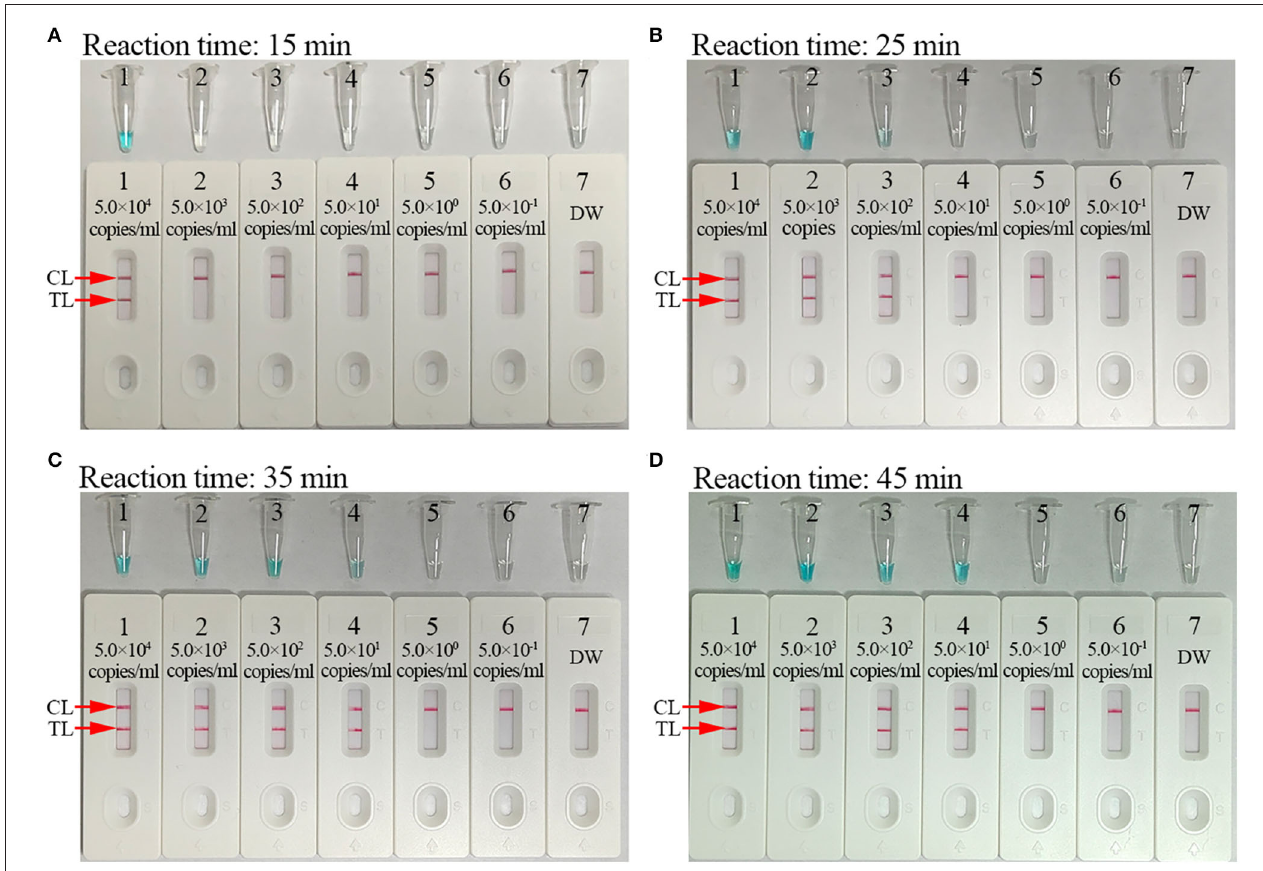
FIGURE 6 | Optimization of reaction time for C. trachomatis -LAMP-LFB assay. Reaction times ( A , 15min; B , 25min; C , 35min; D , 45min) were tested at optimal reaction temperature of 67 ◦ C. Tube/biosensors B1–B7 represent plasmid levels of 5.0 × 10 4 , 5.0 × 10 3 , 5.0 × 10 2 , 5.0 × 10 1 , 5.0 × 10 0 , 5.0 × 10 − 1 , and 5.0 × 10 − 2 copies/ml and blank control (distilled water). The LoD of plasmid template could be detected when the reaction lasted for 35min (C). CL, control line; TL, test